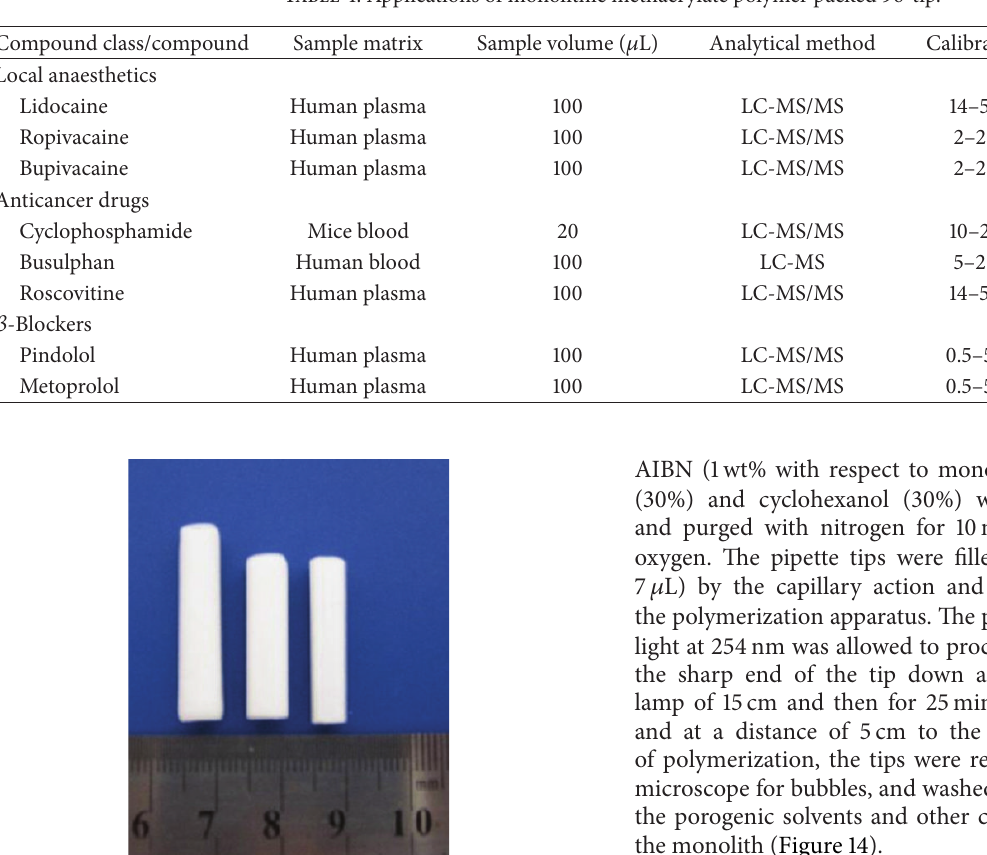
Table 4: Applications of monolithic methacrylate polymer packed 96-tip.